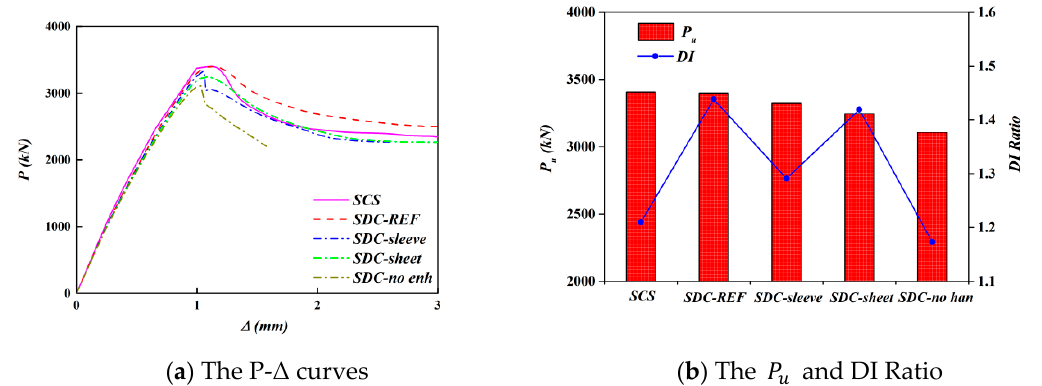
Figure 12. The compressive behavior of SCS wall and SDC walls with different